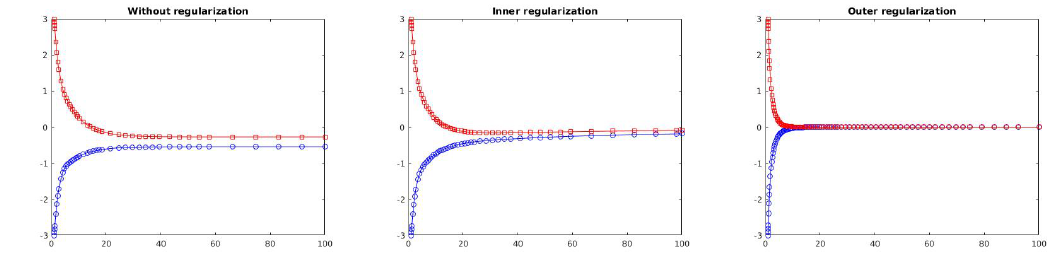
Fig. 2: Trajectories of (FB) , (FBIR) and (FBOR) for λ = 0.5 and γ = 0.15